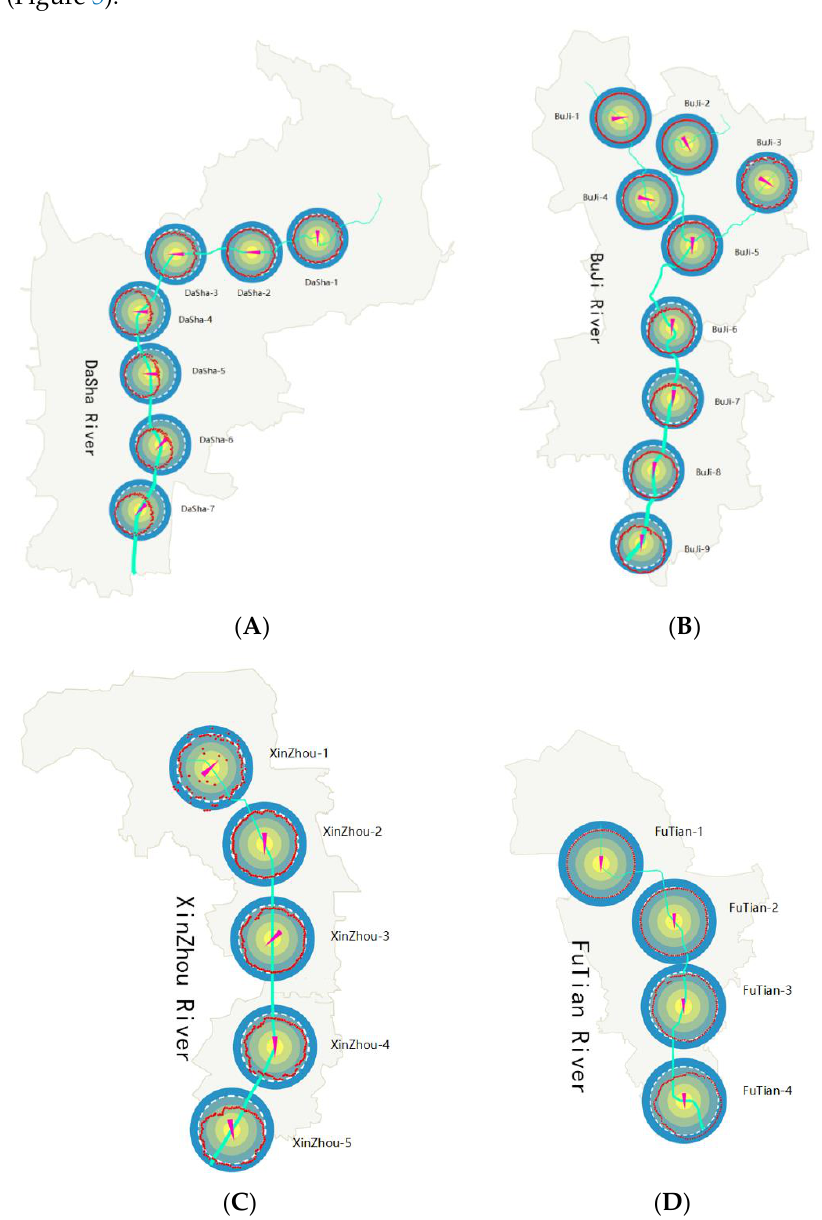
Figure 5. Influence of the peak runoff on the sections of four rivers. ( A ) Dasha River. ( B ) Buji River. ( C ) Xinzhou River. ( D ) Futian River. Only certain parts of the 414 sections are drawn.